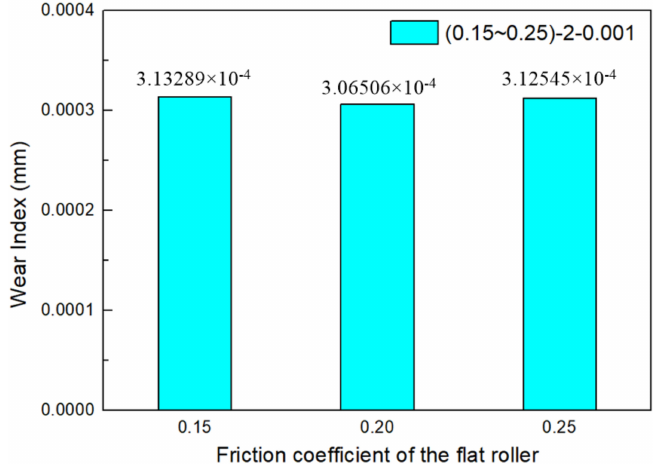
Figure 11. Influence of flat roller friction coefficient on wear depth.